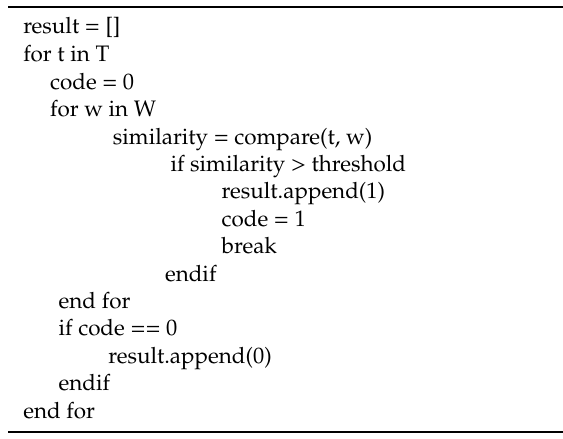
Table 2. The algorithm to select the records with administrative